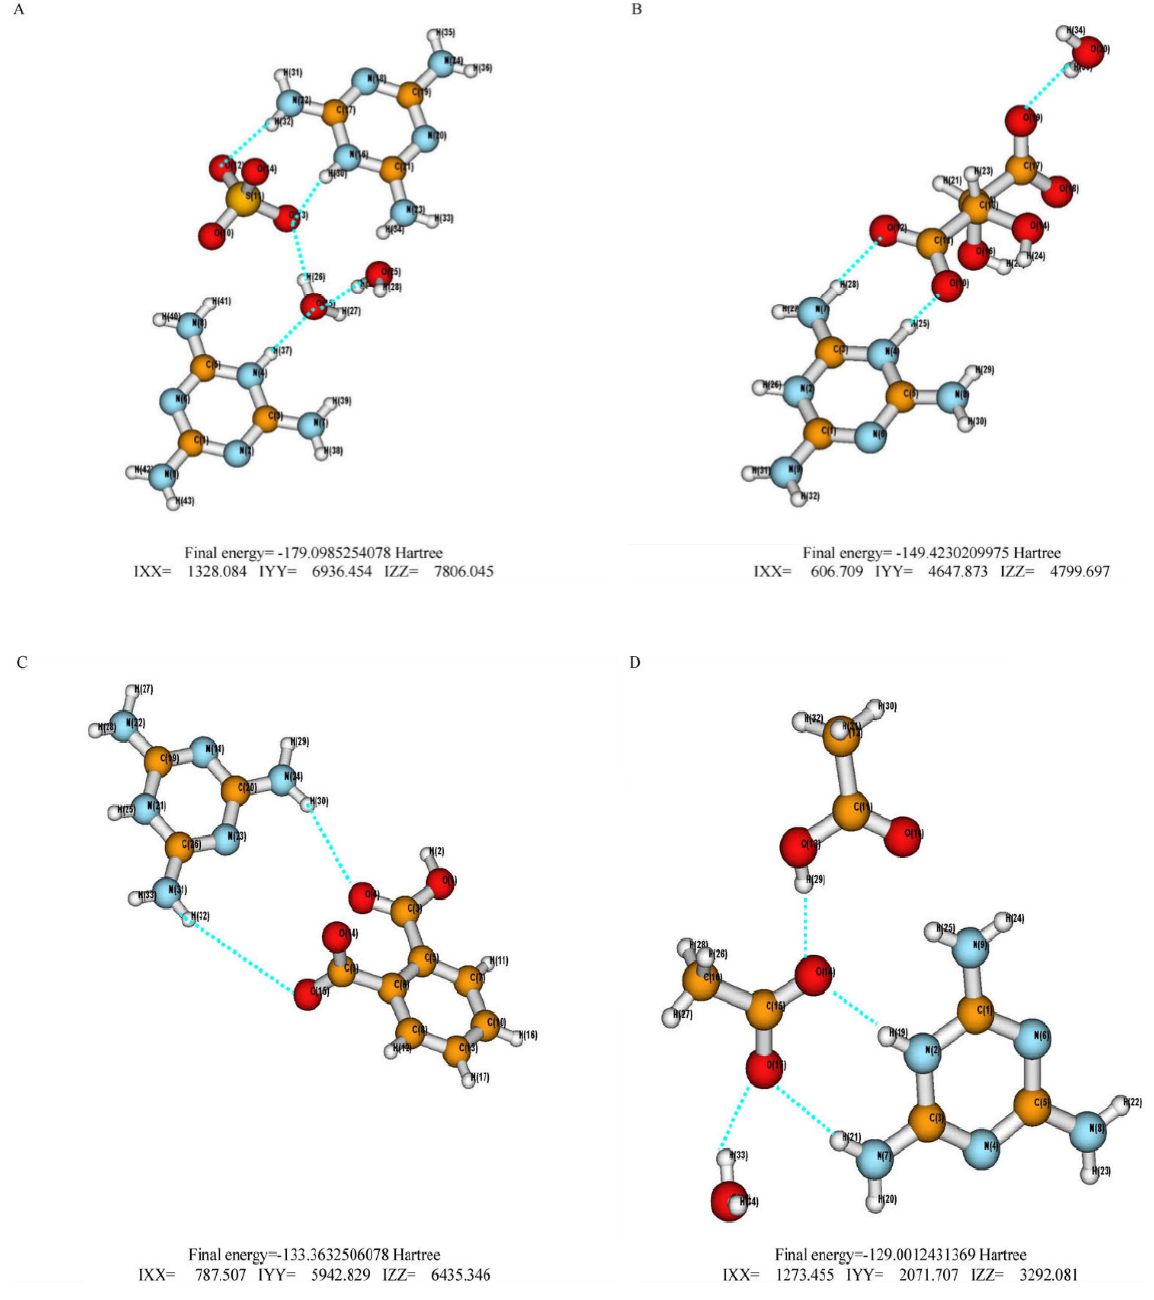
Figure 1. The structures used in calculation with length of bonds [A], energy of calculated form [Hartree]and values of moments of inertia [amu- A 2 ] form each molecule (a-bismelaminium sulphate dihydrate, b – melaminium tartaric acid monohydrate, c – melaminium ftalic acid, d – melaminium acetate acitic acid